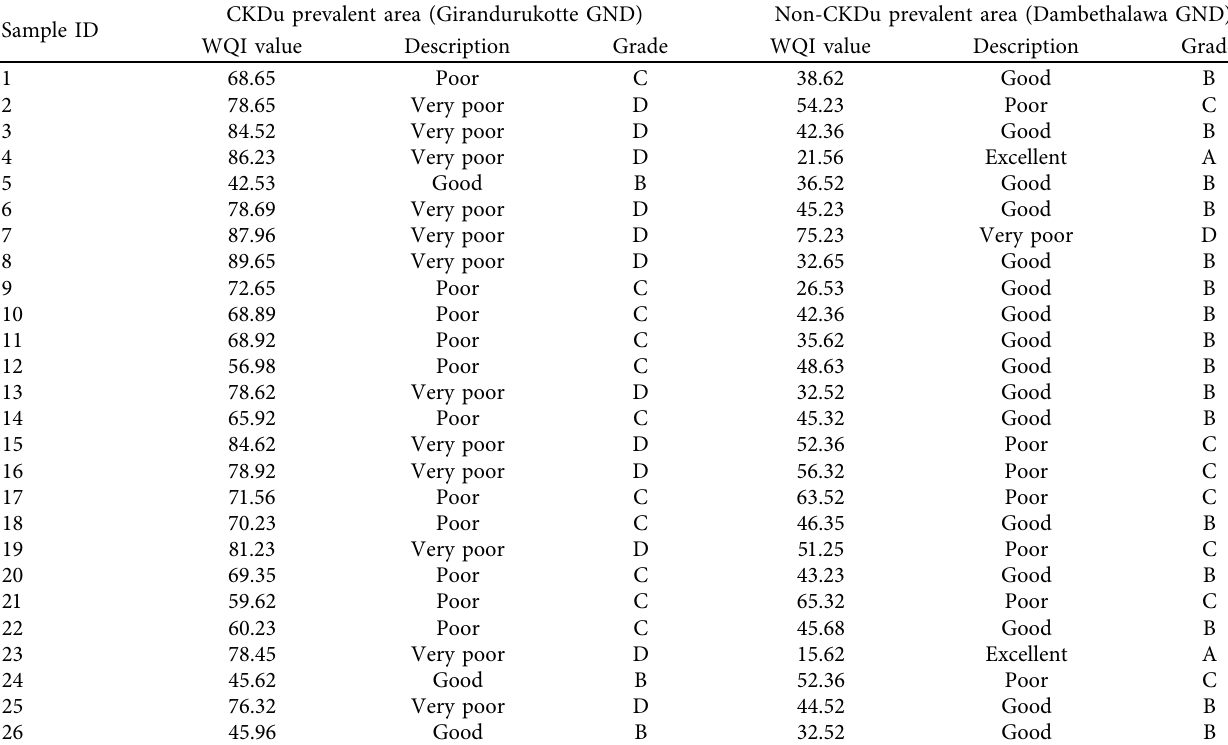
Figure 6: The spatial distribution patterns of (a) fluoride and (b) water hardness in sampling locations of Girandurukotte GND, Badulla District, Sri Lanka. Table 5: Water quality index (WQI) values and the relative description of drinking water samples collected from CKDu prevalent and non- CKDu prevalent areas in Sri